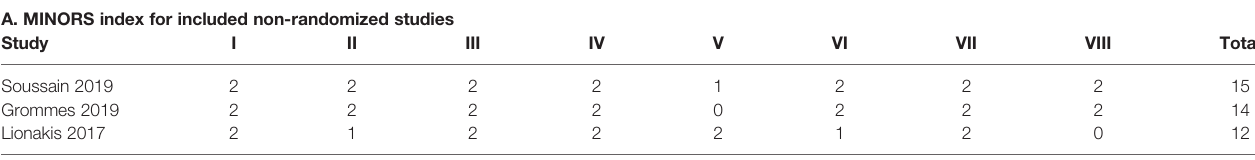
TABLE 2 | Quality assessment of included